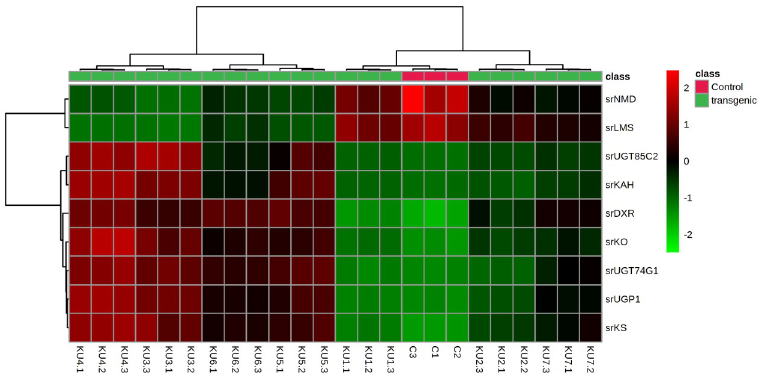
Fig 10. Differential expression of genes in control and transgenic plants. Color scale represents gene expression with red being highest and green lowest.